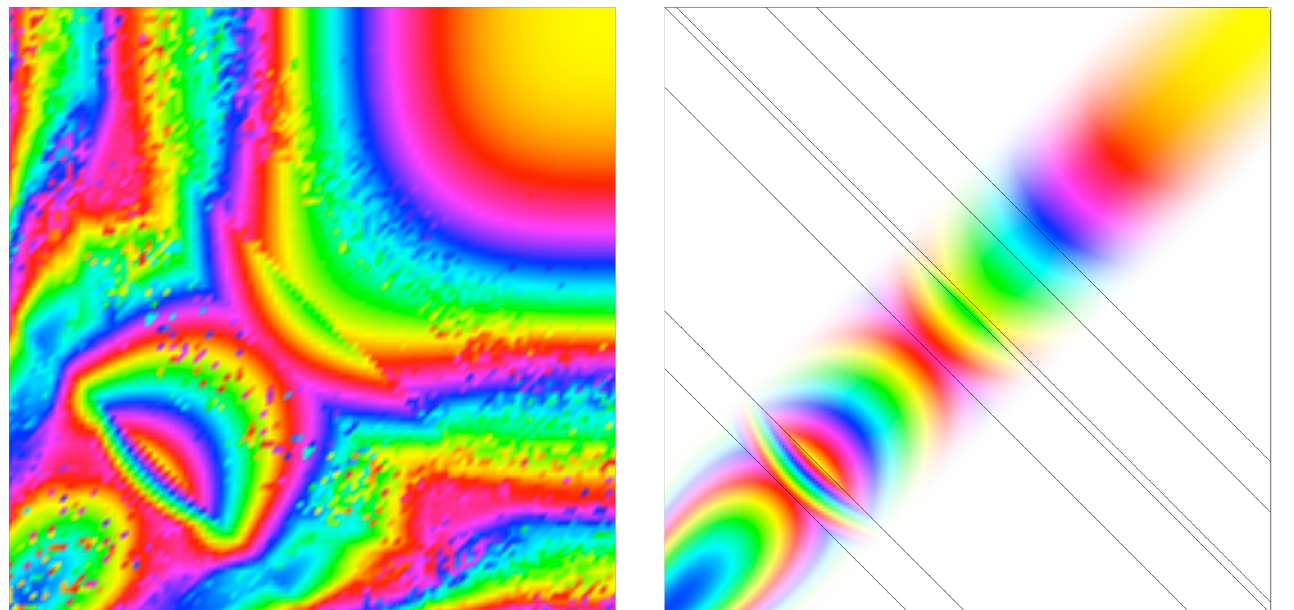
FIG. 15 Contoursofoptimalpackingdensity ϕ forthe 323 · 3 family,numeric(left)versusanalyticalongthesymmetrydiagonal(right).The color gradient {blue, magenta, red, yellow, green, cyan, and blue} represents the ϕ gradient f ϕ − 3 60 ; ϕ − 2 60 ; ϕ − 1 60 ; ϕ ; ϕ þ 1 60 ; ϕ þ 2 60 ; ϕ þ 3 60 g ; yellow contours occur at ϕ ¼ f 7 ; 8 ; 9 ; 1 g . 10 10 10